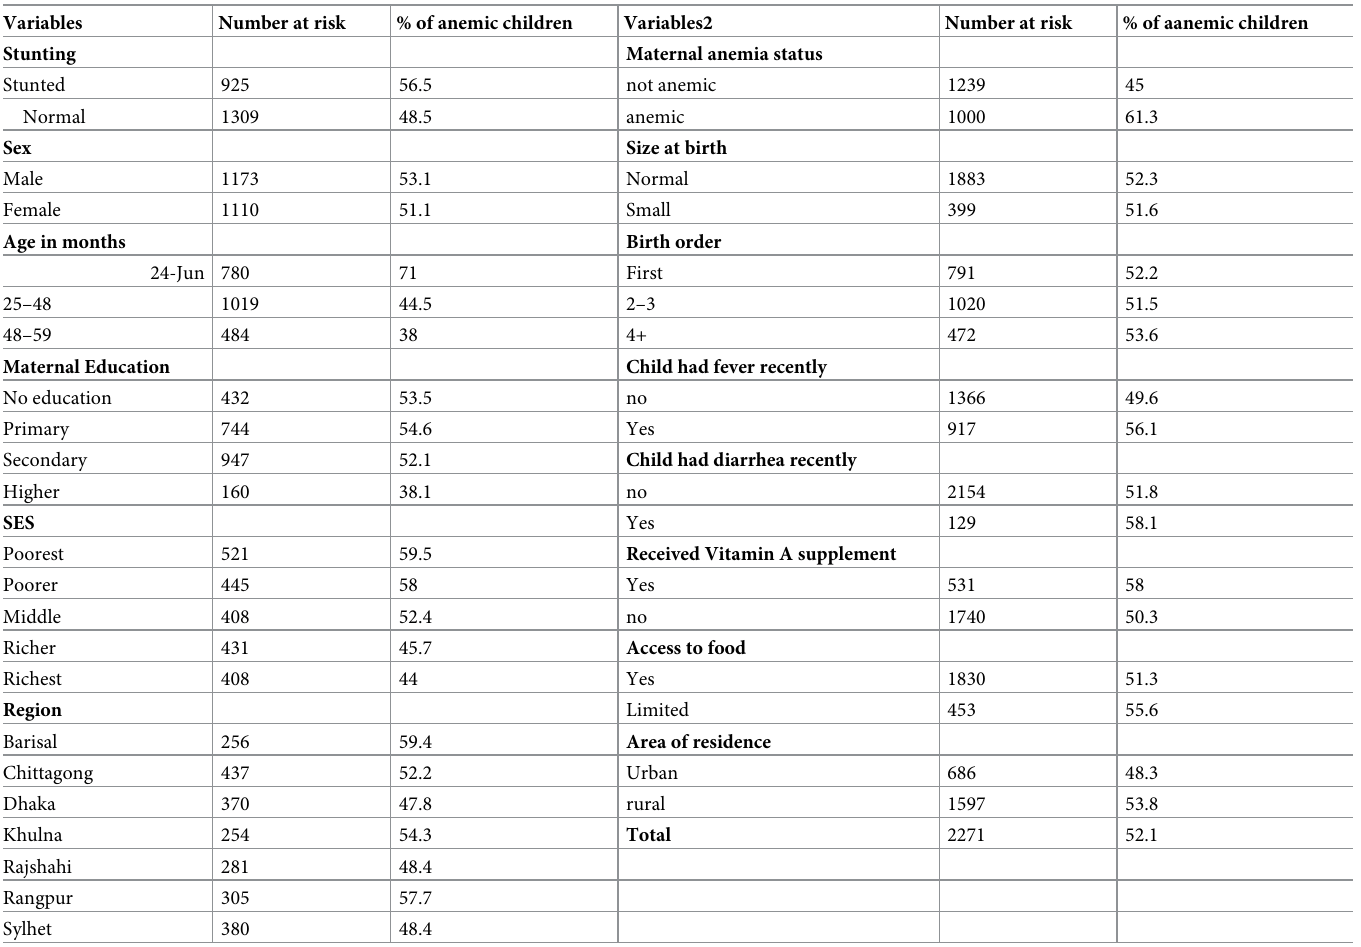
Table 1. Distribution of anemic children by their background